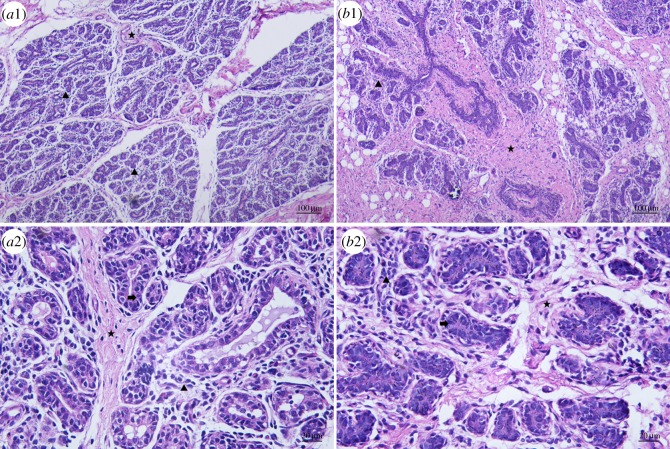
Morphologic characteristics between HMTs and CMMTs by H&E. (a1) and (a2) were the morphology of HMTs under microscope at 100× and 400× magnification, respectively, and (b1) and (b2) were the morphology of CMMTs under microscope at 100× and 400× magnification, respectively. A black arrow indicates mammary epithelium, a star indicates interlobular connective tissues and a triangle indicates intralobular connective tissues.